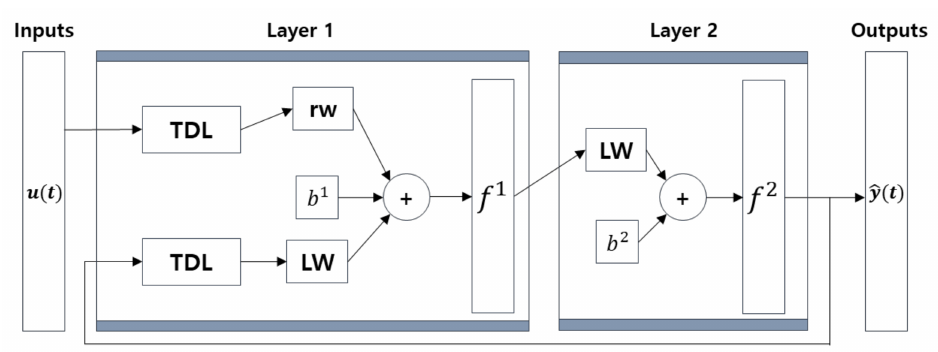
Figure 3. Architecture of NARX